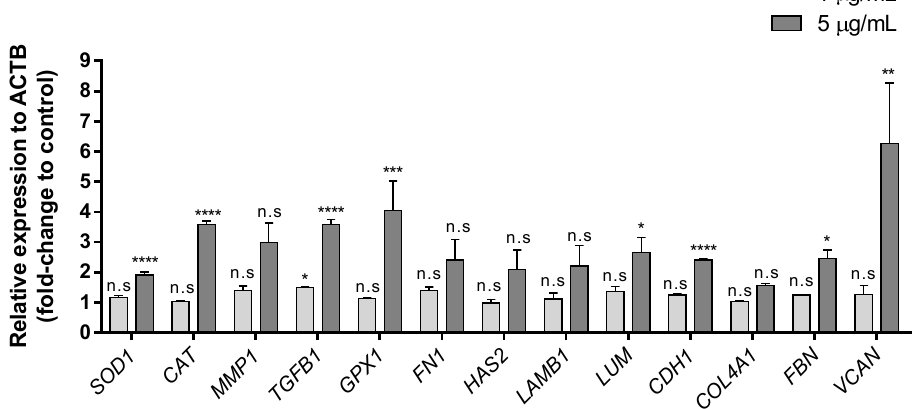
Figure 3. Effects of Zn 2+ on HaCaT cell line after 24-h treatment. Expression of different genes at 1 and 5 µg/mL ZnCl 2 concentration. Data depicted as mean ± SD of three replicates. Results represented as fold-change to control and relative expression to ACTB. Significant differences were determined by one-way ANOVA with Tukey’s correction for multiple comparisons: * p < 0.05; ** p < 0.01; *** p < 0.001; **** p > 0.0001; n.s. = not significant.